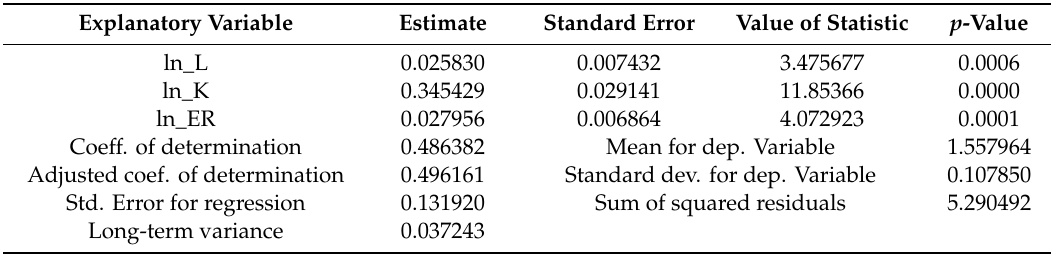
Table 6. Panel data model based on FMOLS estimators to explain GCI growth in the EU countries and UK